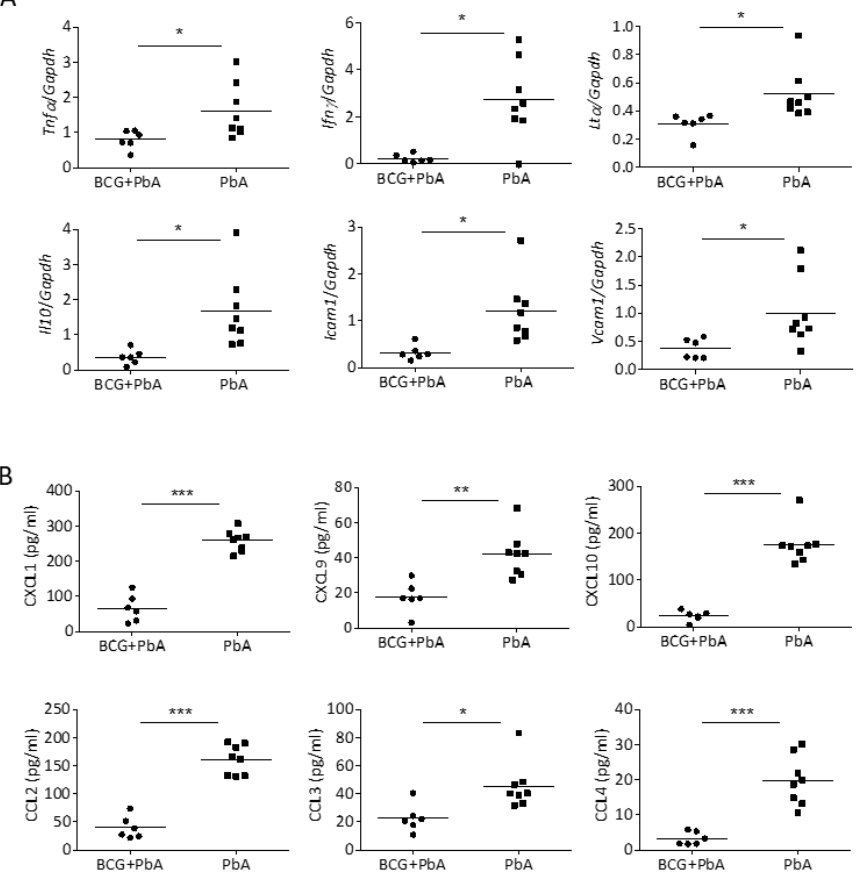
Figure 3. Assessment of immune mediators in the brain. Brains of mice that were or were not immunized with BCG 30 days before PbA SPZ challenge were analysed for the expression of cytokines or adhesion molecules ( A ) by qRT-PCR or for the protein levels of different chemokines by Legendplex ( B ). Data from one of two independent experiments are shown. Symbols and bars represent individual mice and means, respectively (n = 6–8). * p ≤ 0.05; ** p ≤ 0.01; *** p ≤ 0.001 determined by Student’s t -test.